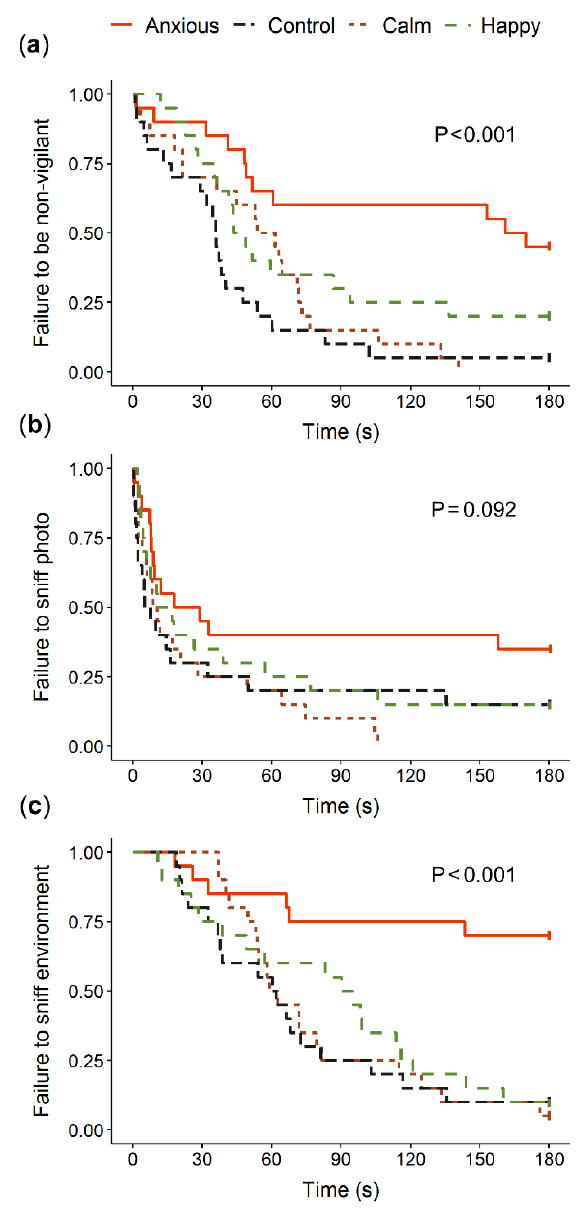
Figure 3. Kaplan-Meier curves for latency to become non-vigilant ( a ), sniff the photo ( b ) and sniff the environment ( c ). The probability on the Y -axis drops at each time the given behavior was exhibited by an individual in the treatment group.